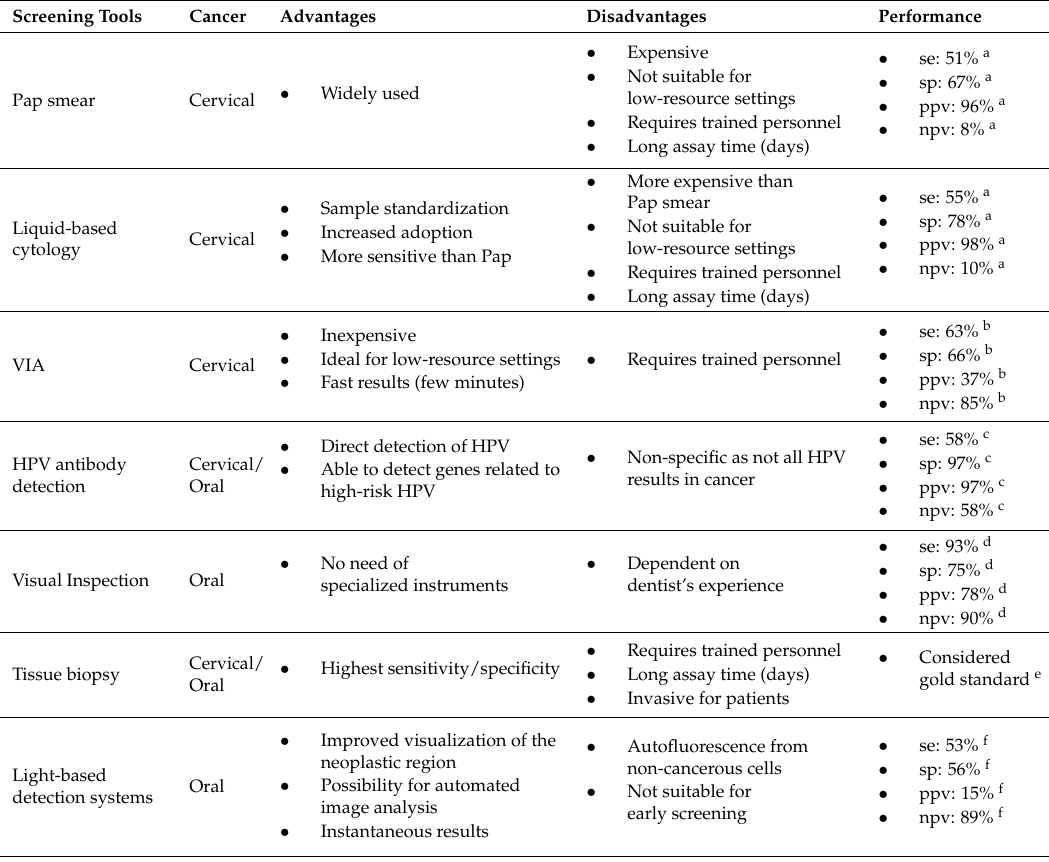
Table 1. Advantages and disadvantages of traditional cancer screening tools for cervical and oropharyngeal